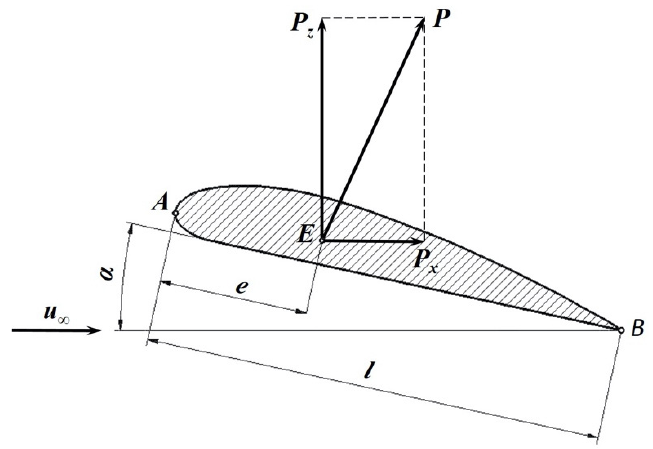
Figure 1. Resultant aerodynamic forces. Center of pressure.